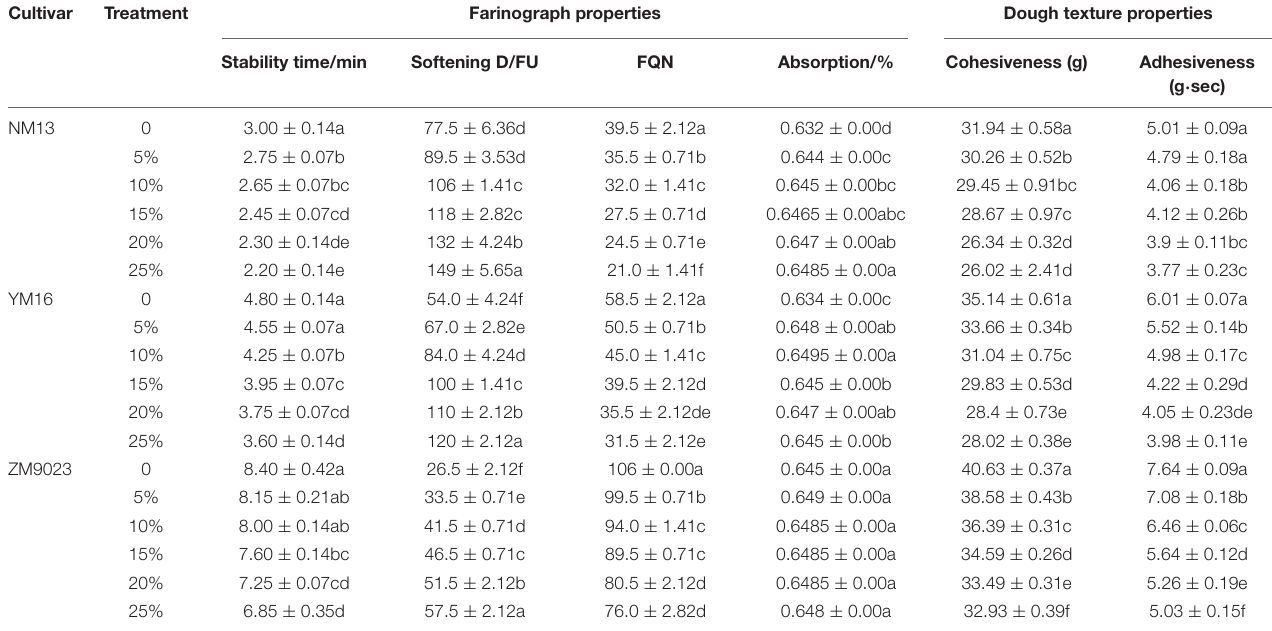
TABLE 2 | Effect of additional amount of starch on dough rheology of wheat. Cultivar